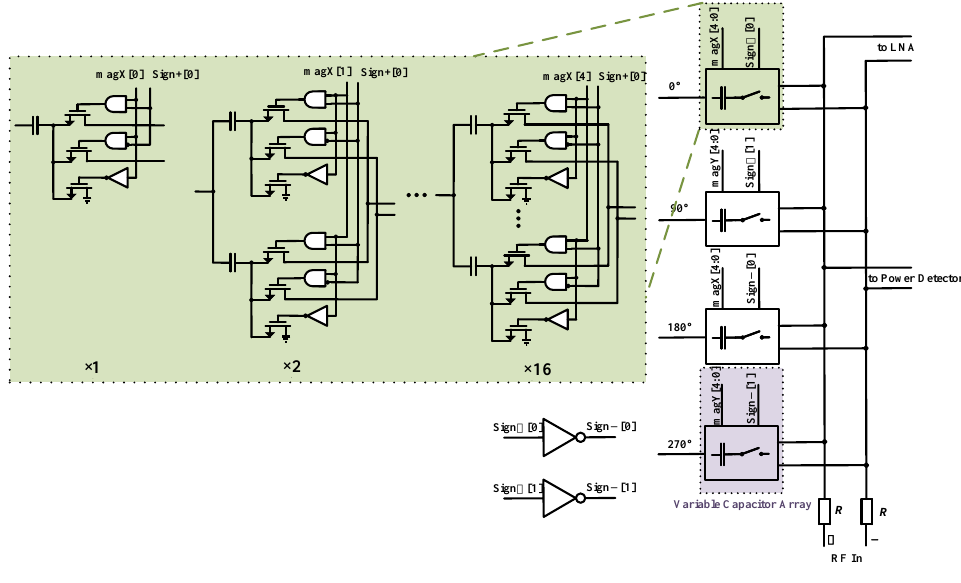
Figure 7. Variable capacitor network and signal combiner circuit. Figure 8 shows all possible cancellation points after the cancellation signal passes through the variable capacitor network and signal combiner circuit in an ideal case. The polarity control bits determine the quadrant of the cancellation signal. The amplitude control bits determine the coordinate values of I and Q channels. Assuming that the amplitude attenuation of the variable capacitor unit circuit is linear, the adjacent cancellation points are equidistant. To achieve the result that the self-jamming signal can be